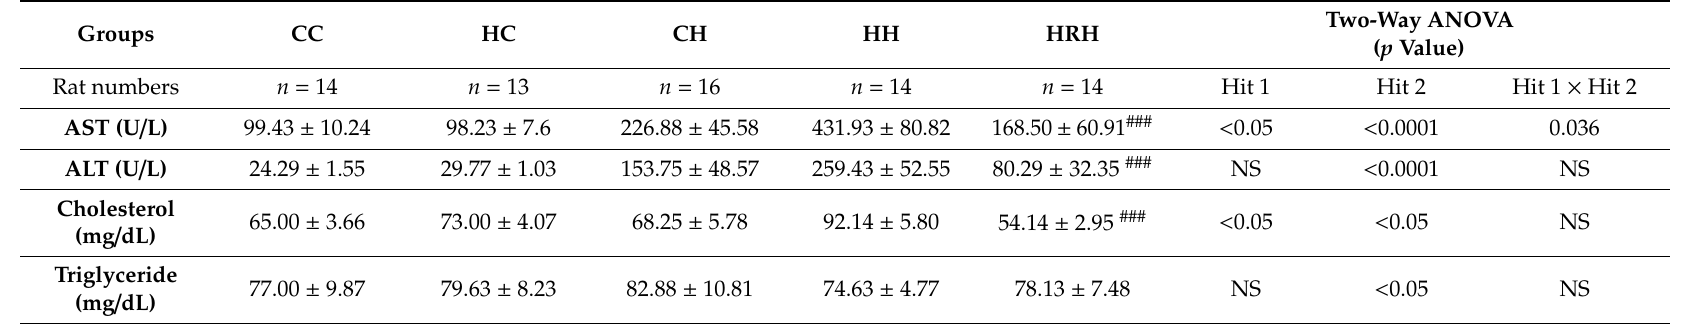
Table 1. Biochemistry of adult male o ff spring in rats with maternal high-fat diet (HFD) / obesity and postnatal high-fat